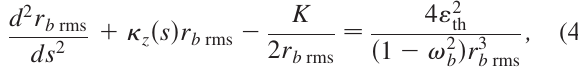
ffiffiffiffiffiffiffiffiffiffiffiffi p 4 " S versus the normal- th ffiffiffiffiffiffiffiffiffiffiffi p (cid:7) ð s Þ ¼ ð 2 = 3 Þ 1 = 2 (cid:8) ½ 1 z 0